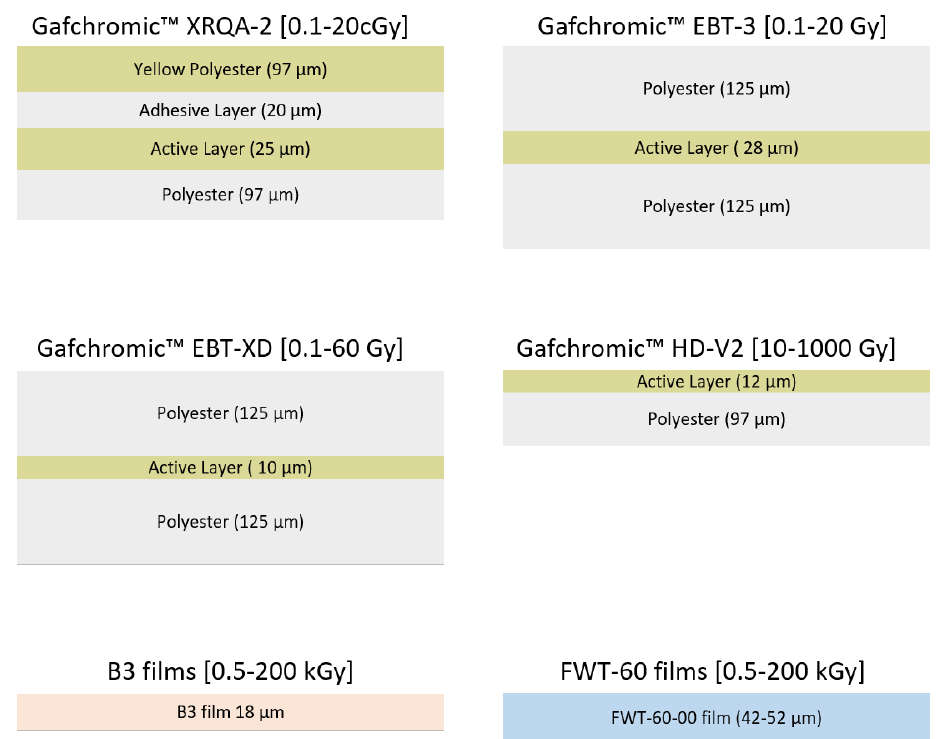
Figure 1. Structure and dynamic range of some radiochromic film (RCF)